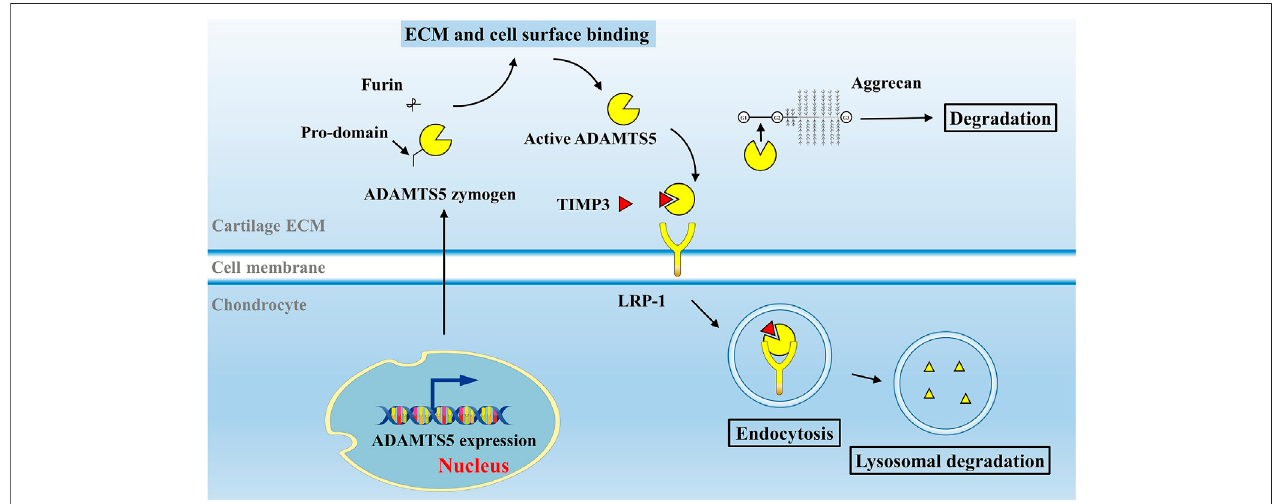
FIGURE2| ActivationanddegradationmechanismofADAMTS5 invivo .Innormalcartilage,ADAMTS5isactivatedunderthestimulationofin fl ammatoryfactorsor breakdown products in cartilage ECM. After the removal of its pro-domain by furins, activated ADAMTS5 cleaves the aggrecan core protein at its speci fi c Glu-Xaa recognition motifs. ADAMTS5 can be inhibited by its endogenous inhibitor, TIMP3. ADAMTS5, together with TIMP3 are subsequently endocytosed by chondrocyte via LRP-1 receptor and degraded. Abbreviations: tissue inhibitor of metalloproteinase 3, TIMP3; lipoprotein receptor – related protein 1,